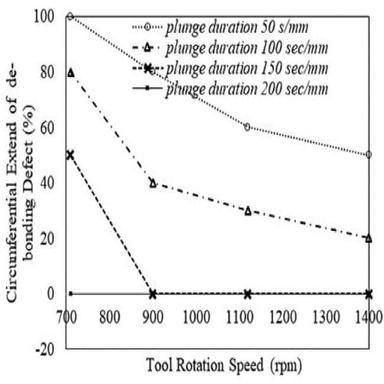
Variation of root de-bond defect with tool rotation speed for various plunge durations.